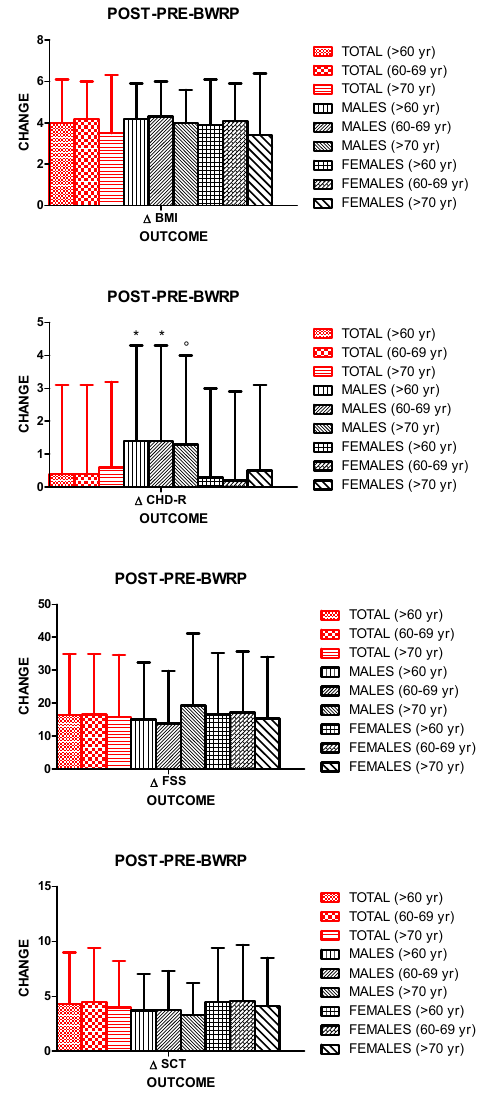
Figure 3. Changes of body mass index ( ∆ BMI, top panel), coronary heart disease risk ( ∆ CHD-R, top middle panel), fatigue severity scale ( ∆ FSS) score (bottom middle panel) and stair climbing test ( ∆ SCT) time (bottom panel) before and after a three-week body weight reduction program (POST-PRE-BWRP) in elderly obese females and males. Data are expressed as mean ± SD. The values corresponding to each gender- and age-related subgroup (total, females / males, > 60 years, 60–69 years and > 70 years) are reported. * p < 0.01 compared to the corresponding female subgroup; ◦ p < 0.01 compared to females aged 60–69